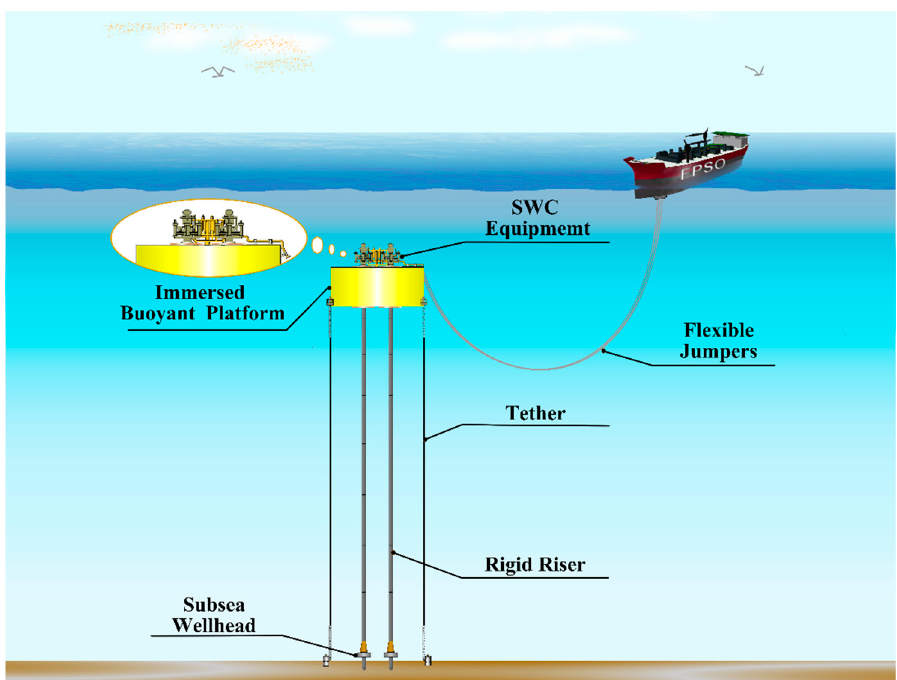
Figure 1. Sketch of the NextGen